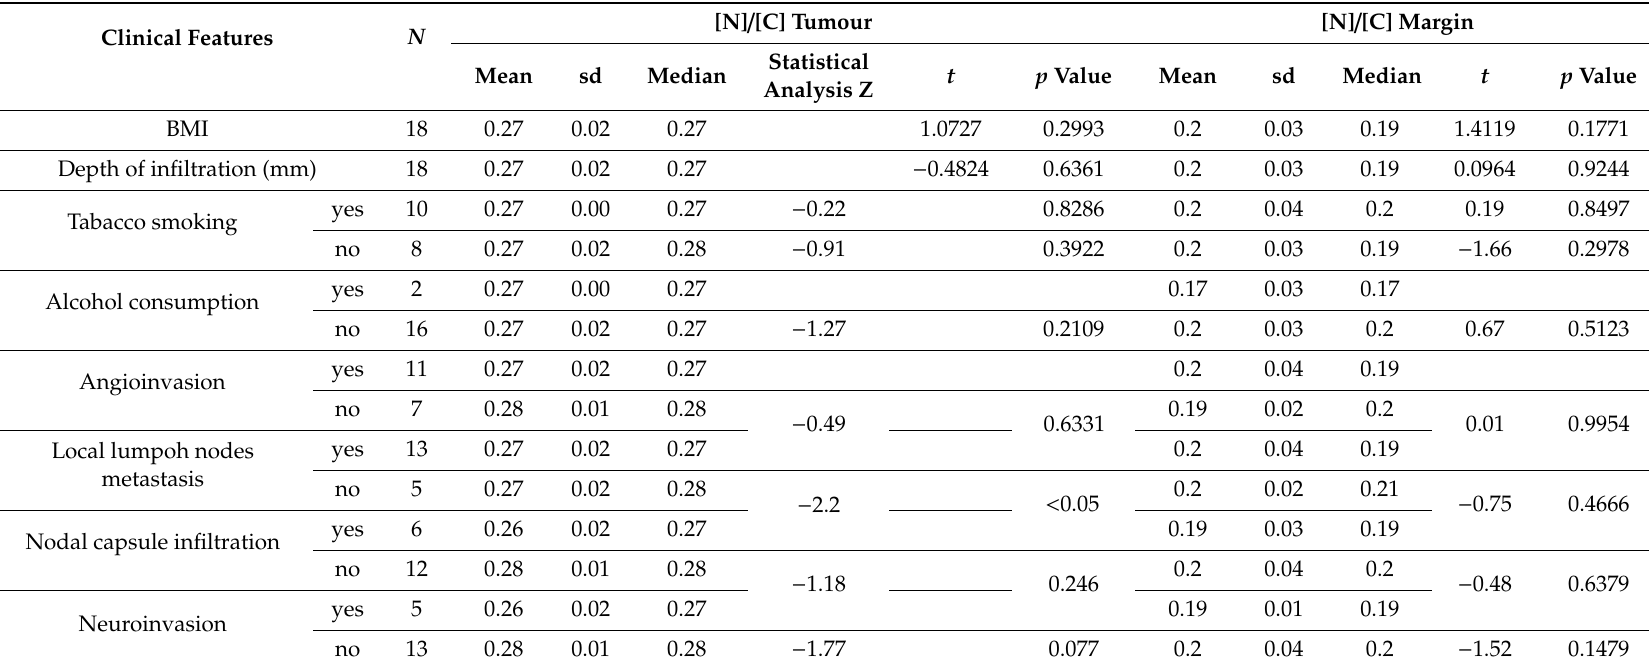
Table 5. Comparison of total nitrogen-to-carbon ratio N / C in tumour and margin and clinical